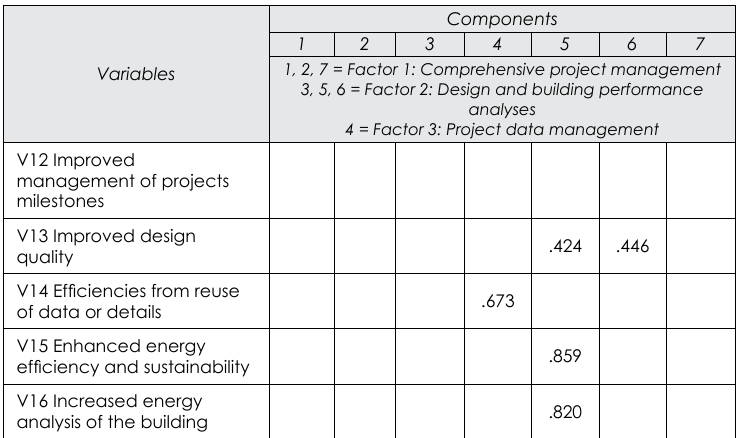
Table 7: Rotated component matrix for BIM benefits